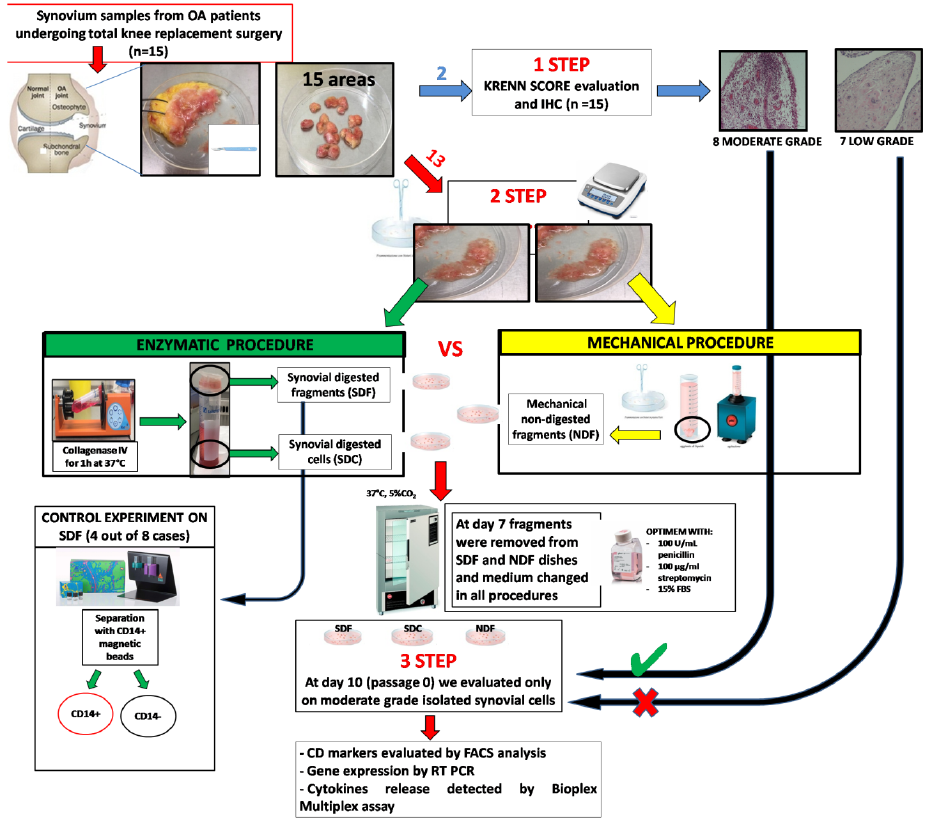
Figure 1. Experimental plan. Synovium samples were selected from 15 OA (osteoarthritis) patients undergoing total knee replacement. From each sample, approximately 15 areas were selected and 2 of them were analysed by histology for Krenn score evaluation (STEP 1) and immunohistochemistry